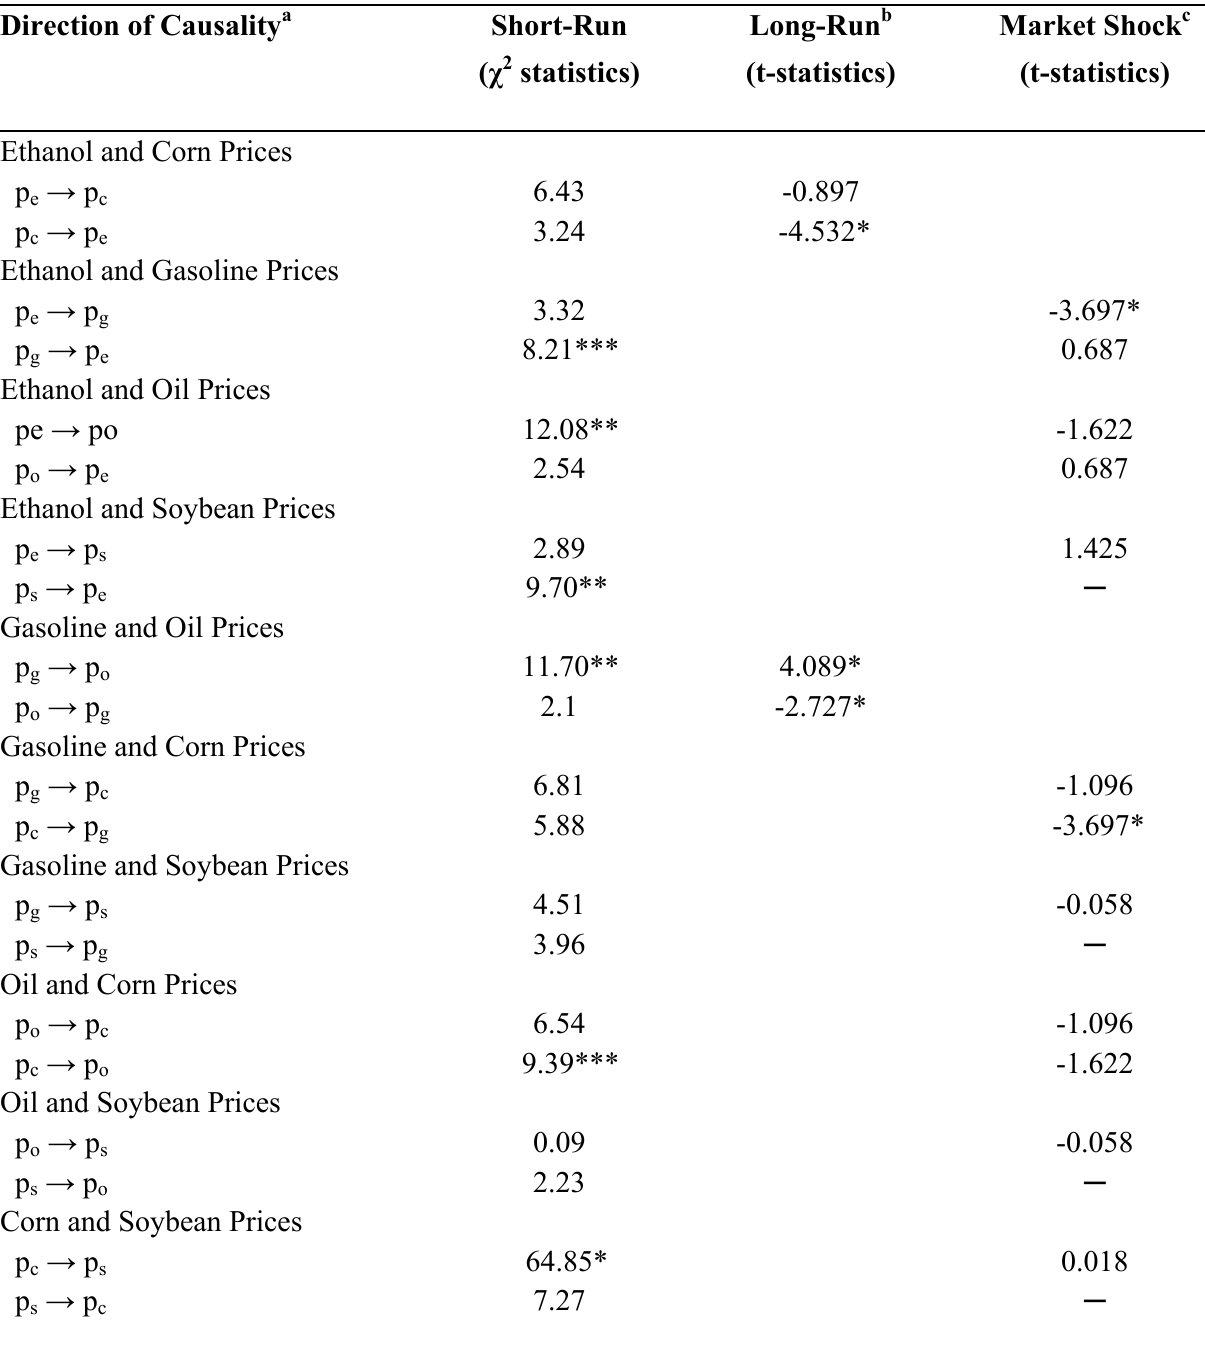
Table A3. Granger Causality Tests for the Pre-Ethanol Boom 1989 –